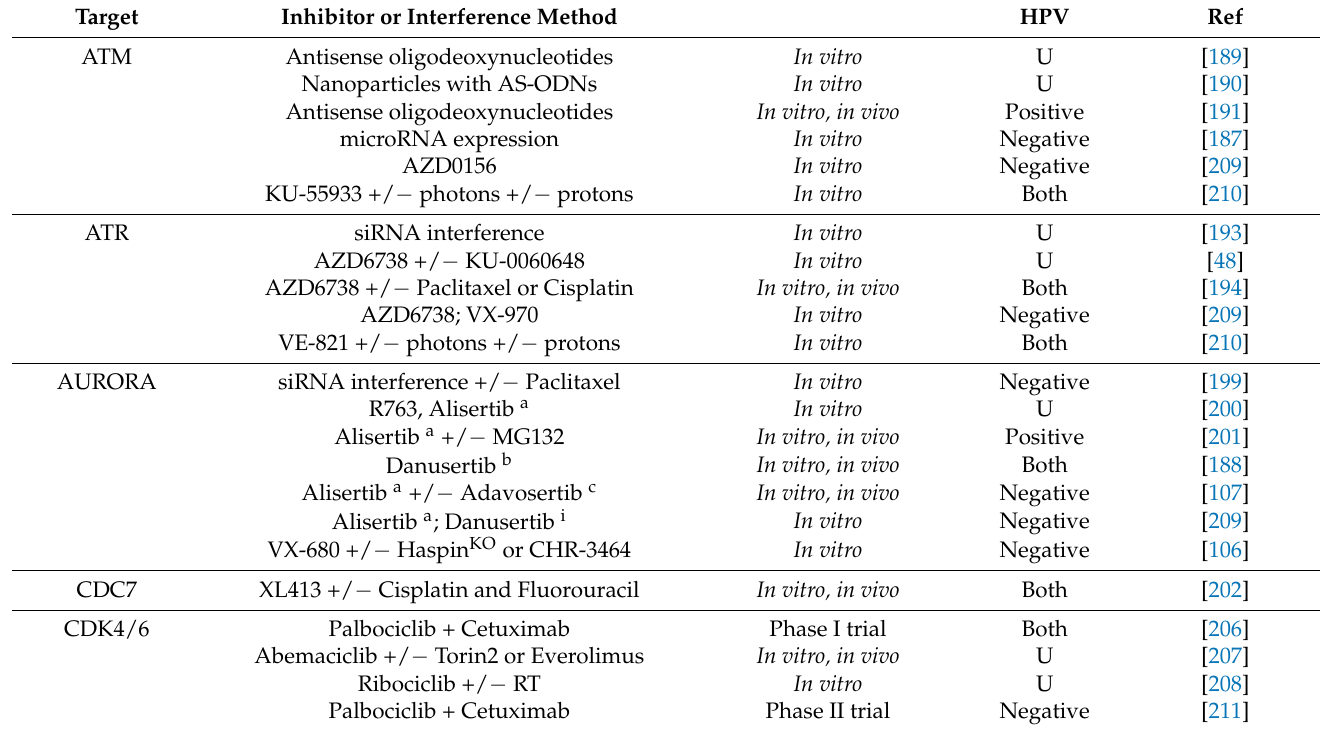
Table 1. Preclinical studies referring to druggable hits in cell cycle